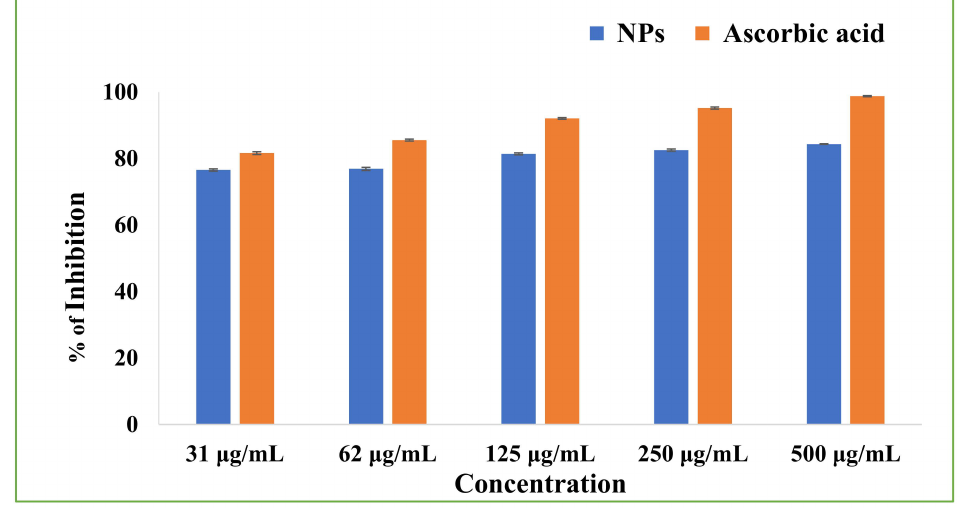
Figure 15. DPPH scavenging activity of Cu-Zn-Mn mixed trimetal oxide nanoparticles.